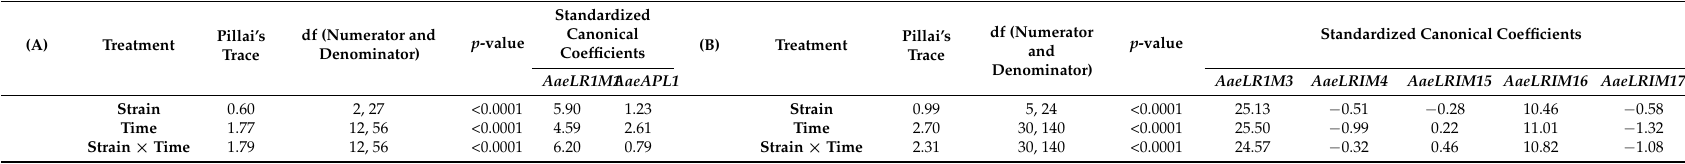
Table 5. ( A ) MANOVA results for strain and time effects of AaeLRIM1 and AaeAPL1 RNA profile in response to chikungunya virus infection of Ae. aegypti . ( B ) MANOVA results for strain and time effects of paralogues of AaeAPL1 RNA profile in response to chikungunya virus infection of Ae. aegypti